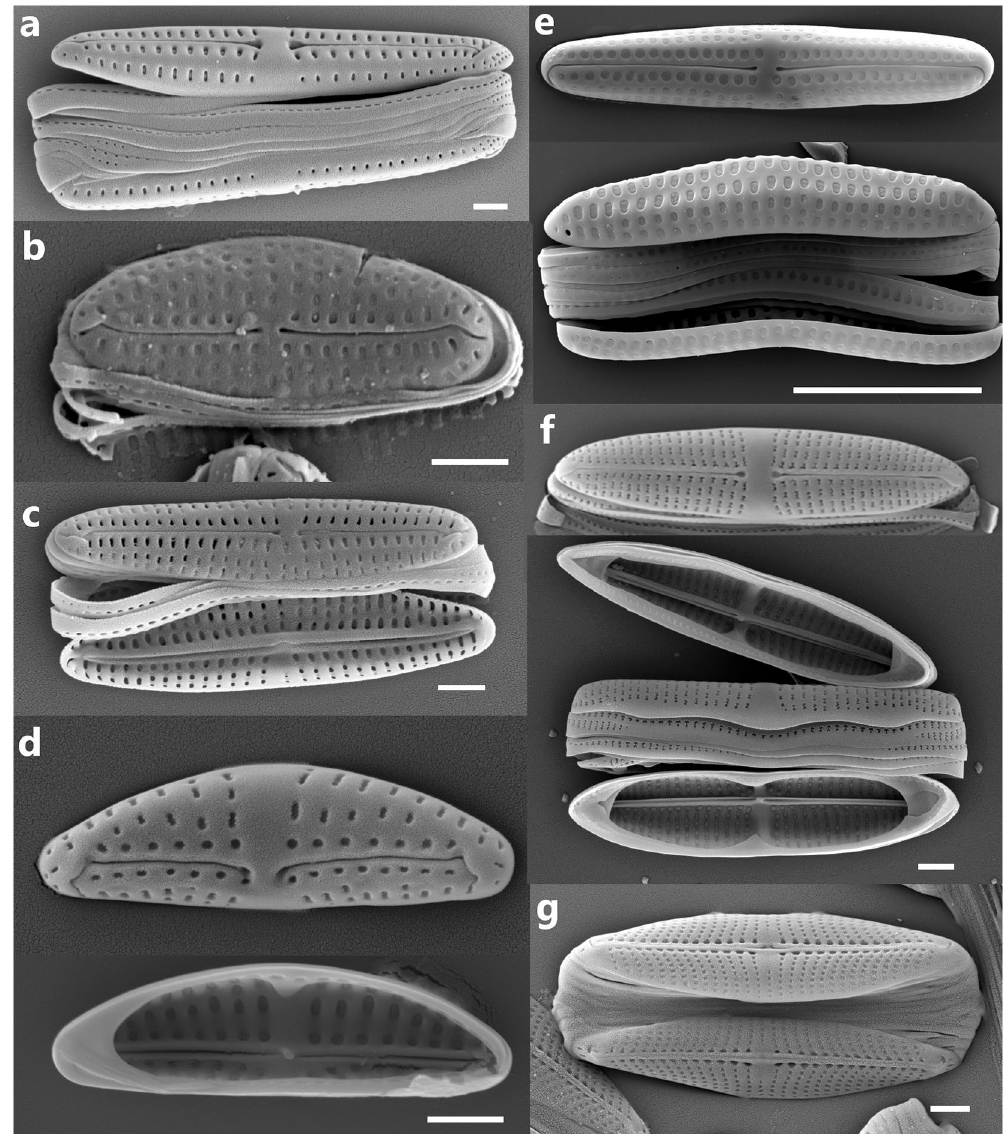
Figure 3. Scanning electron micrographs of some of the POE diatom taxa successfully cultured and sampled for DNA. a = Poulinea lepidochelicola HK630, complete frustule. b = Chelonicola cf costaricensis Majewska 21C, valve exterior. c = Chelonicola sp. Majewska 40A, complete frustule. d = Medlinella amphoroidea HK600 (valve exterior above, interior below). e = Achnanthes elongata HK563 (valve exterior above, complete frustule below). f = Tursiocola denysii HK633 (valve exterior above, complete frustule below). g = Proschkinia vergostriata HK552, complete frustule. All scale bars = 1